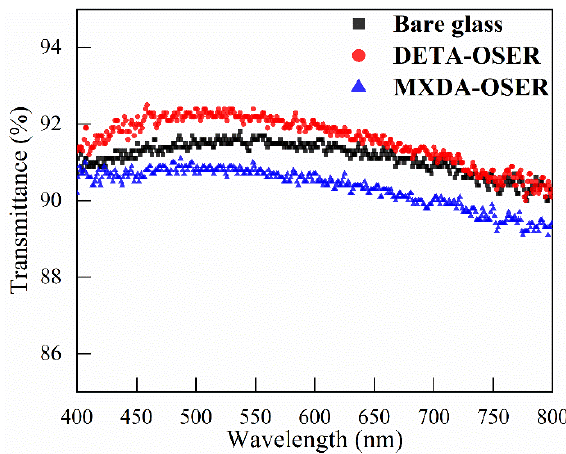
Table 2. Refractive index and thickness of the DETA-OSER, MXDA-OSER and bare glass.